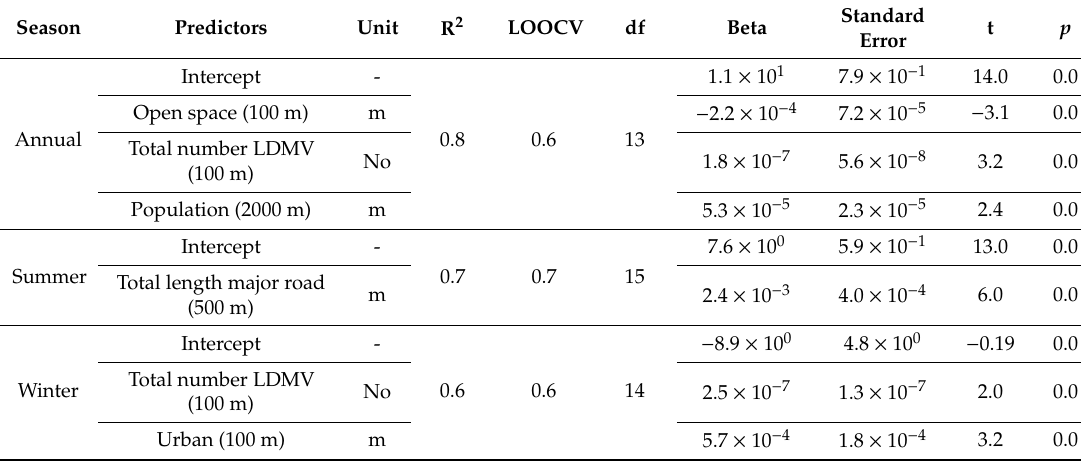
Table 5. Annual, summer, and winter PM 2.5 LUR model